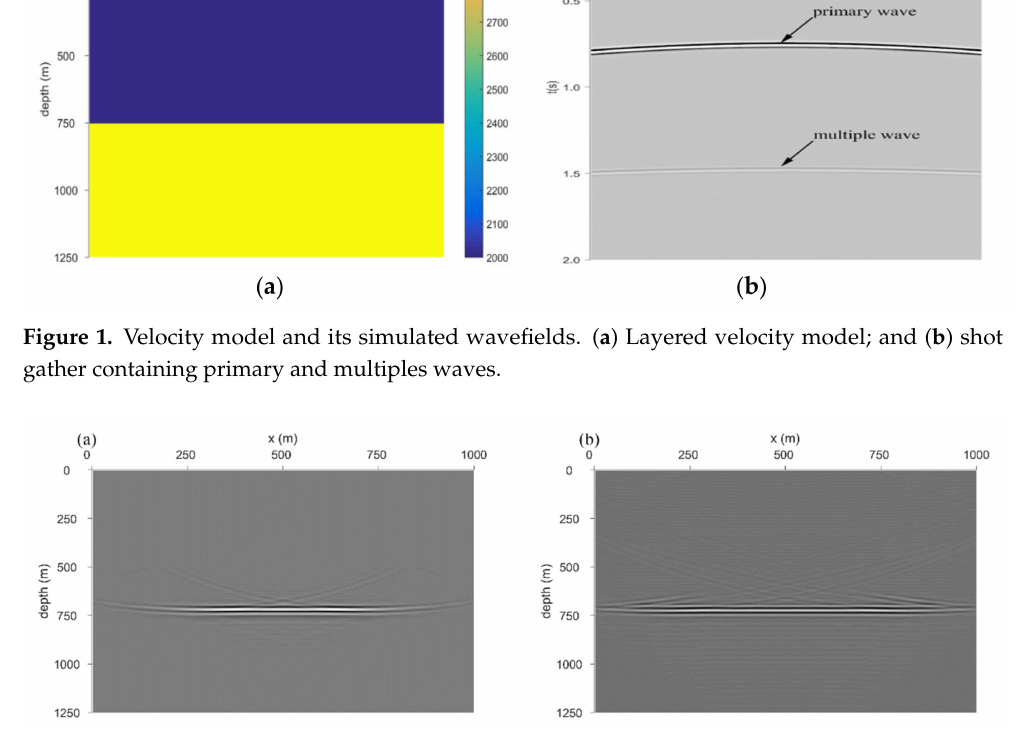
Figure 2. The imaging results obtained by using ( a ) primary waves; and ( b ) multiple